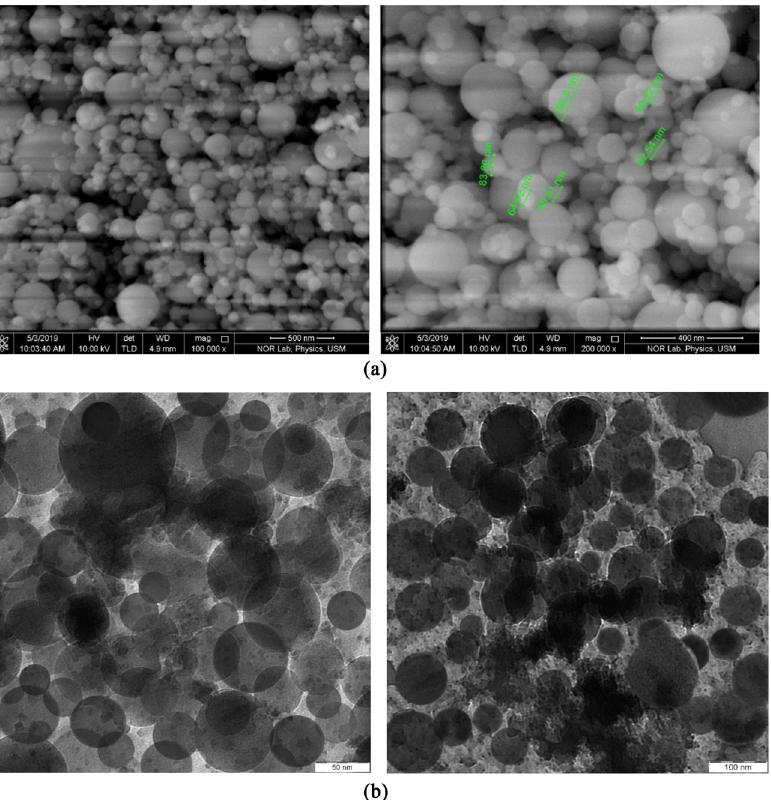
Figure 1: ( a ) FE - SEM and ( b ) TEM images of the NSS, adapted from ref. [ 13 ] .